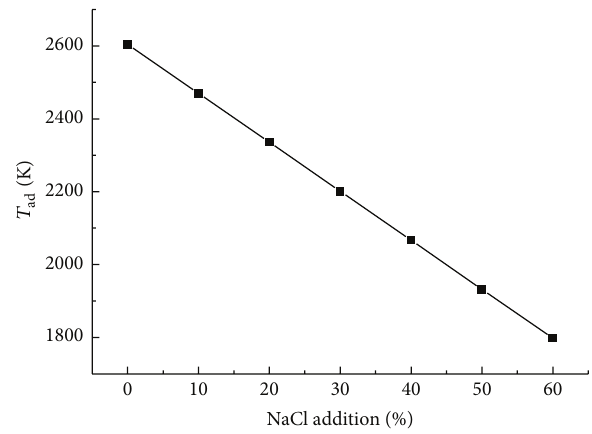
Figure 1: Change of 𝑇 ad with the addition of